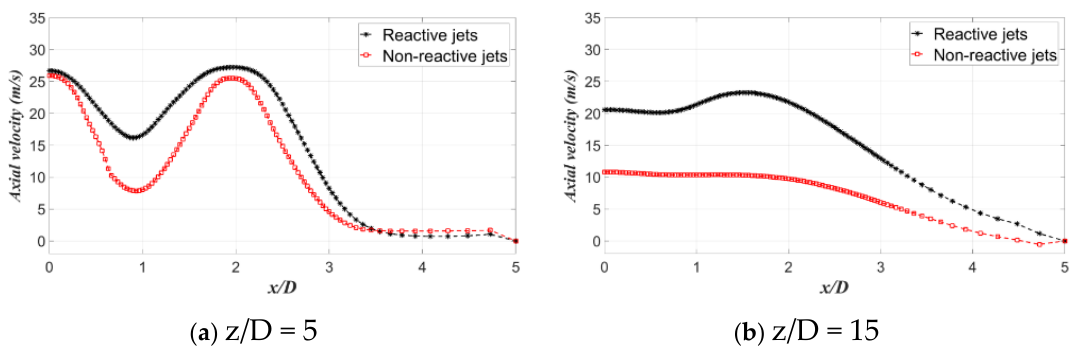
Figure 14. Axial velocity distribution in radial direction.